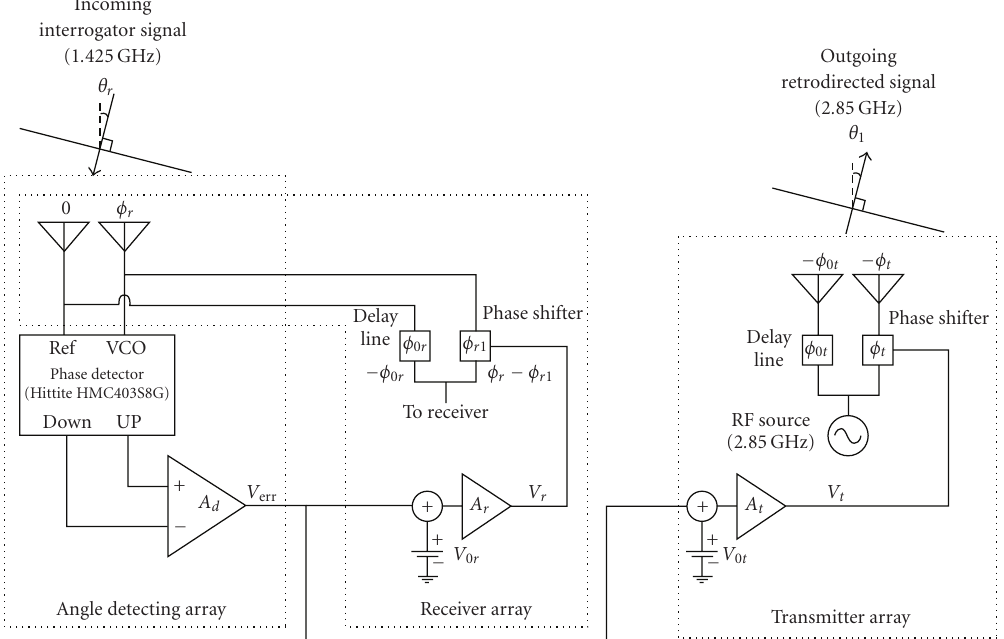
Figure 11: Schematic of a retrodirective array using phase detection and phase shifting.